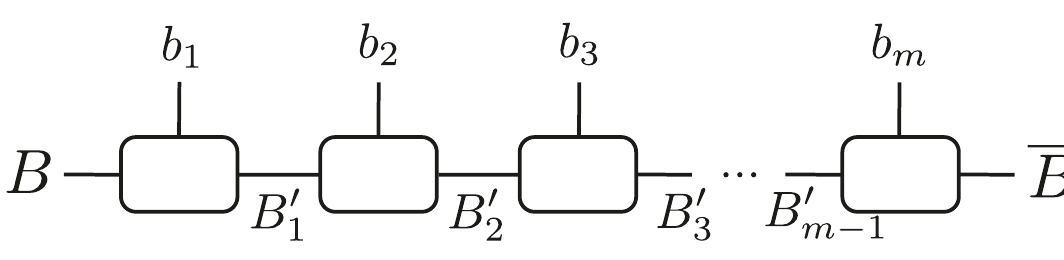
Figure 8 . Random tensor network used to demonstrate reconstruction outside the max-EW. Each box is a tripartite random tensor with “bulk” leg b , connected to the two tensors on either side i of it with maximally entangled “in-plane” legs B 0 and B 0 . The tensors on the ends each have a i − 1 i single “boundary” leg, B or B . Which bulk legs are reconstructable on B depends on two things: the dimensions of the in-plane legs and the state on the bulk legs. A lower bound on the size of this reconstructable region is the max-EW, but it could be larger, depending on how much helpful information there is from the legs in the